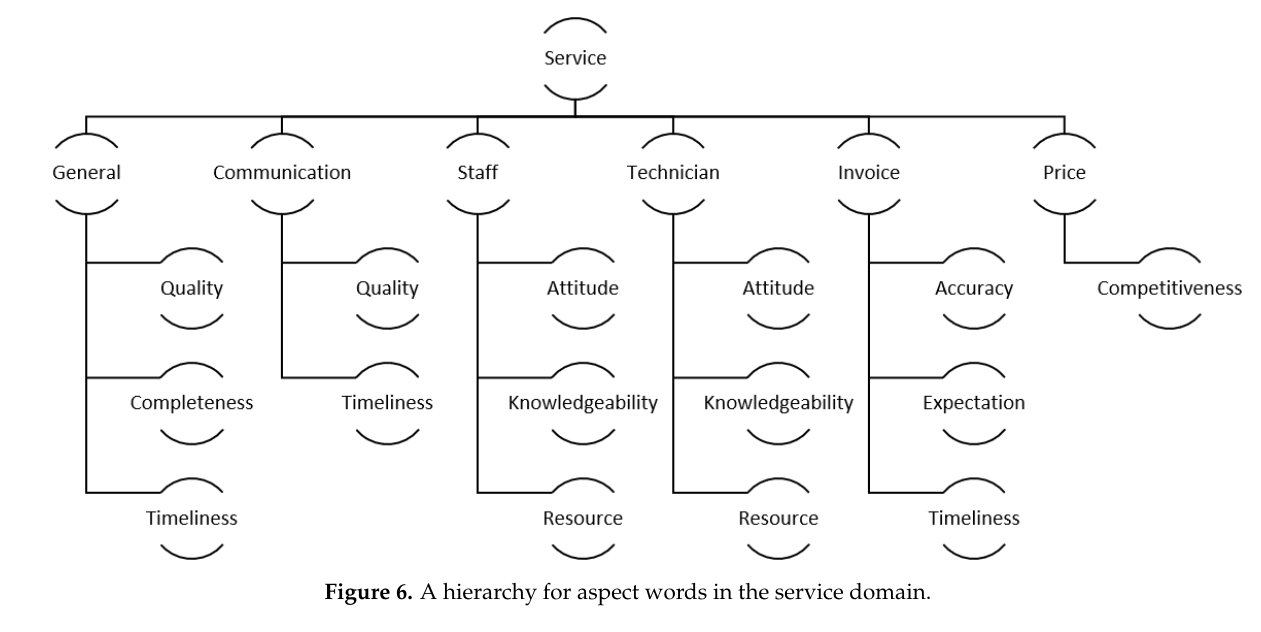
Figure 6. A hierarchy for aspect words in the service domain.